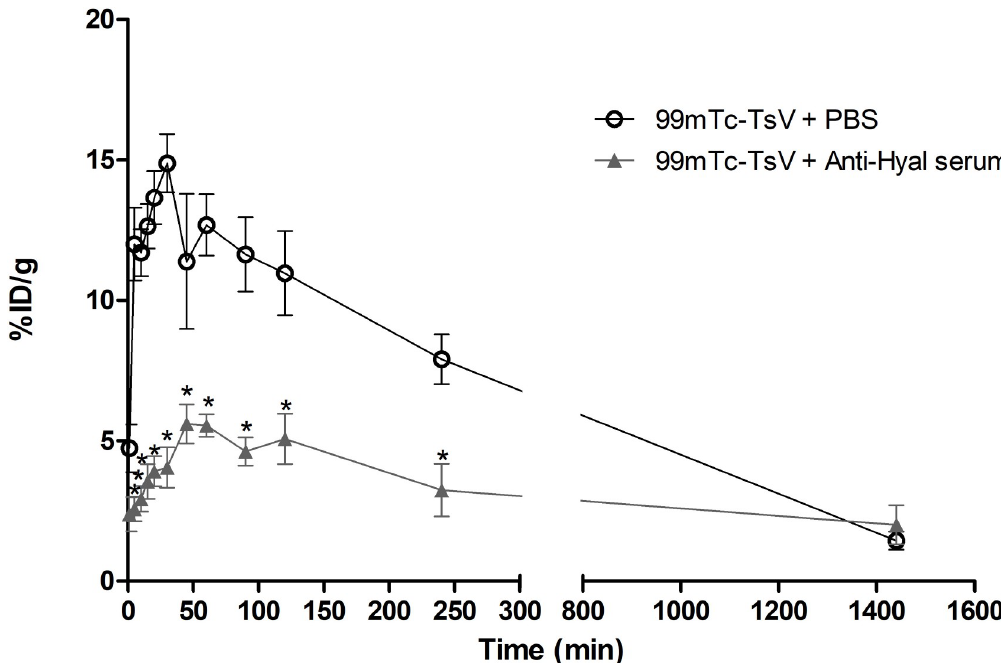
Fig 3. Blood clearance of 99mTc-TsV. 3.7 MBq of 99mTc-TsV diluted in PBS (99mTc-TsV + PBS) or neutralized with anti-hyaluronidase serum (99mTc-TsV + Anti-Hyal serum) was intramuscularly injected in Swiss mice (6–8 weeks old, 24–28 g; n = 6 per group). Radioactivity levels were measured in blood samples at 1, 5, 10, 15, 20, 30, 45, 60, 90, 120, 240, and 1440 min post-injection. Data are represented as the mean percentage of the injected dose of 99mTc-TsV per gram of blood (% ID/g) ± S.E.M. of the mean. Values represent duplicates from two independent experiments. Statistical analyses were performed using a linear mixed model. Serum administration (p < 0.0001), time (p < 0.0001), and their interaction (p < 0.0001) had a statistically relevant effect on the mean 99mTc-TsV blood